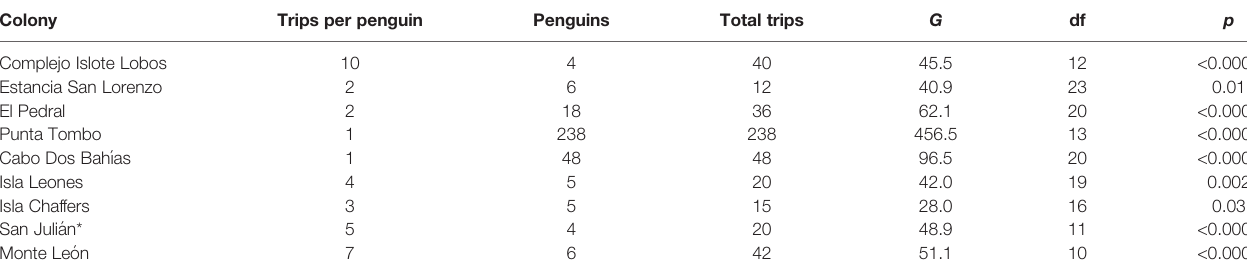
TABLE 2 | Foraging locations of Magellanic penguins breeding at 9 colonies in Argentina were not uniformly distributed around colonies. Colony Trips per penguin